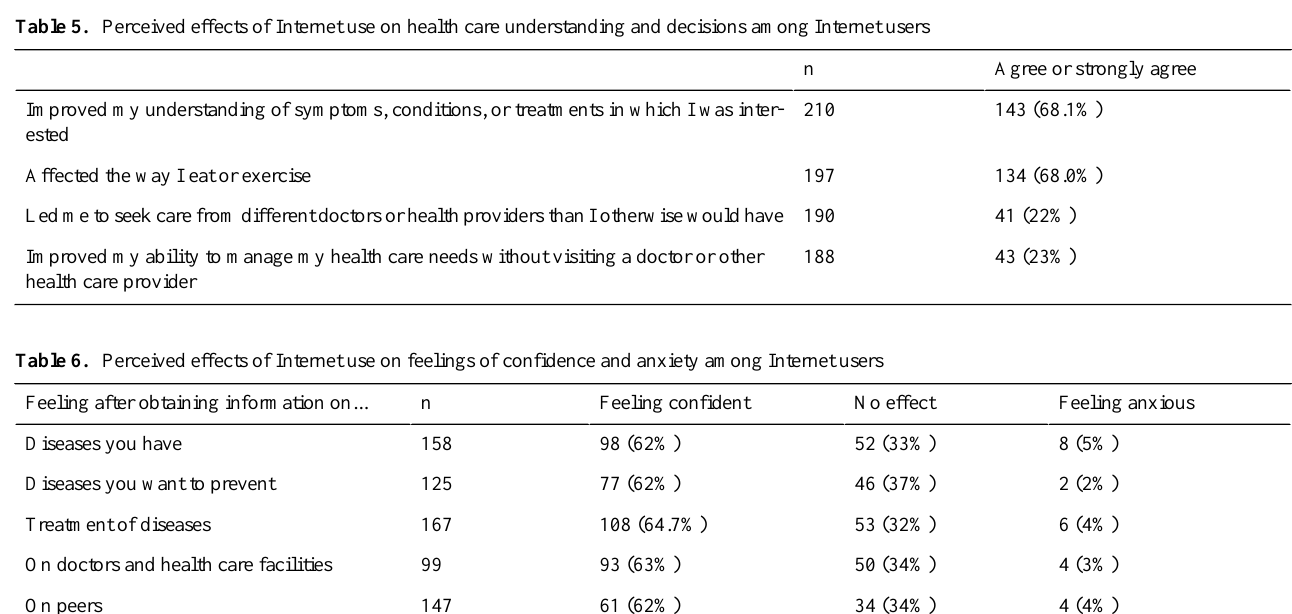
Table 5. Perceived effects of Internet use on health care understanding and decisions among Internet users